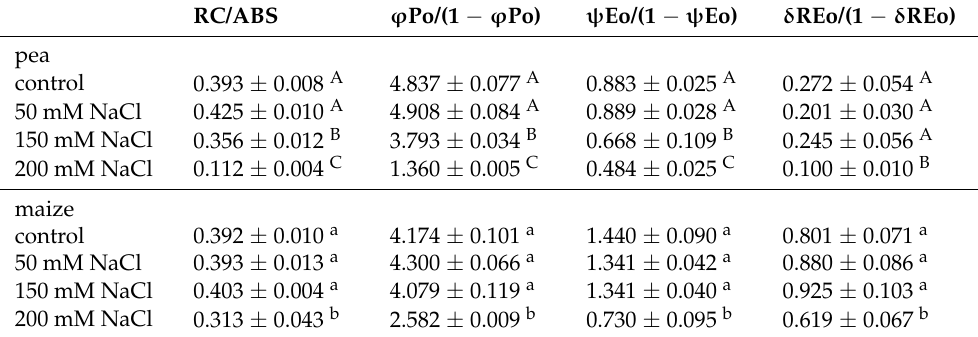
Table 2. Effects of different NaCl concentrations on the components of the performance indices PI ABS and PI total in leaves of pea and maize. The parameters are in relative units. Mean values ( ± SE) are from 20 independent measurements. Different letters indicate significant differences for the respective parameters at p < 0.05 (uppercase for pea and lowercase for